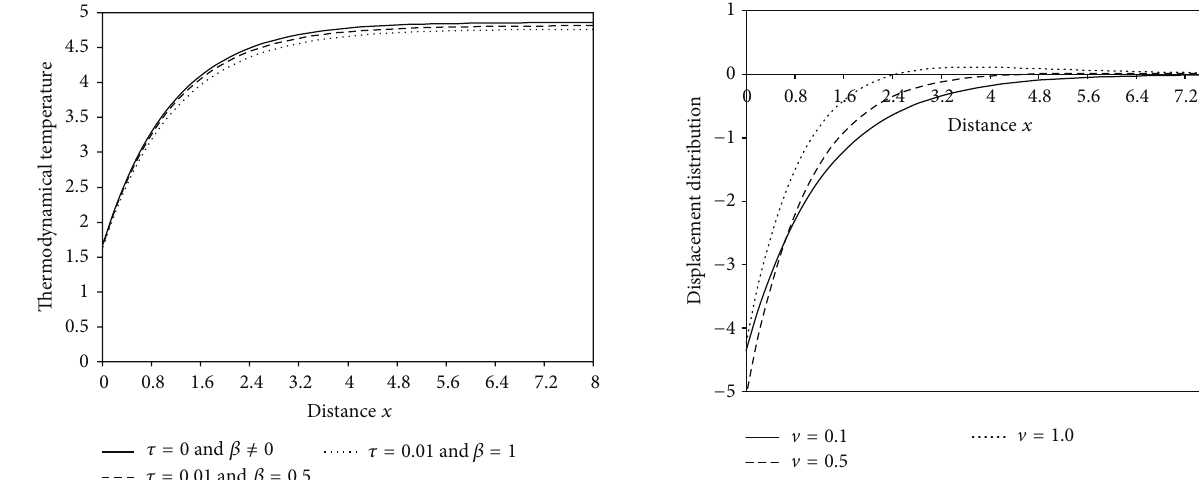
Figure 3: Profile of thermodynamical temperature distribution.